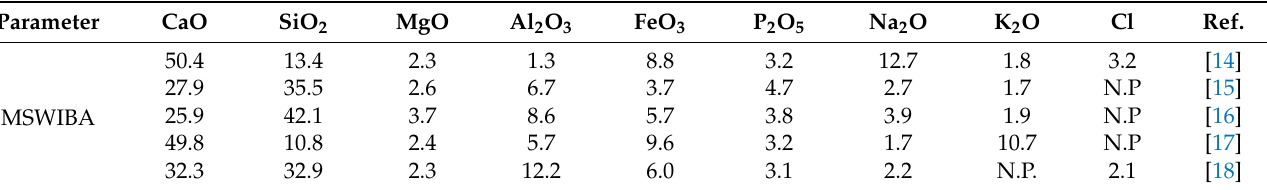
Table 1. Oxide analysis of selected MSWIBAs